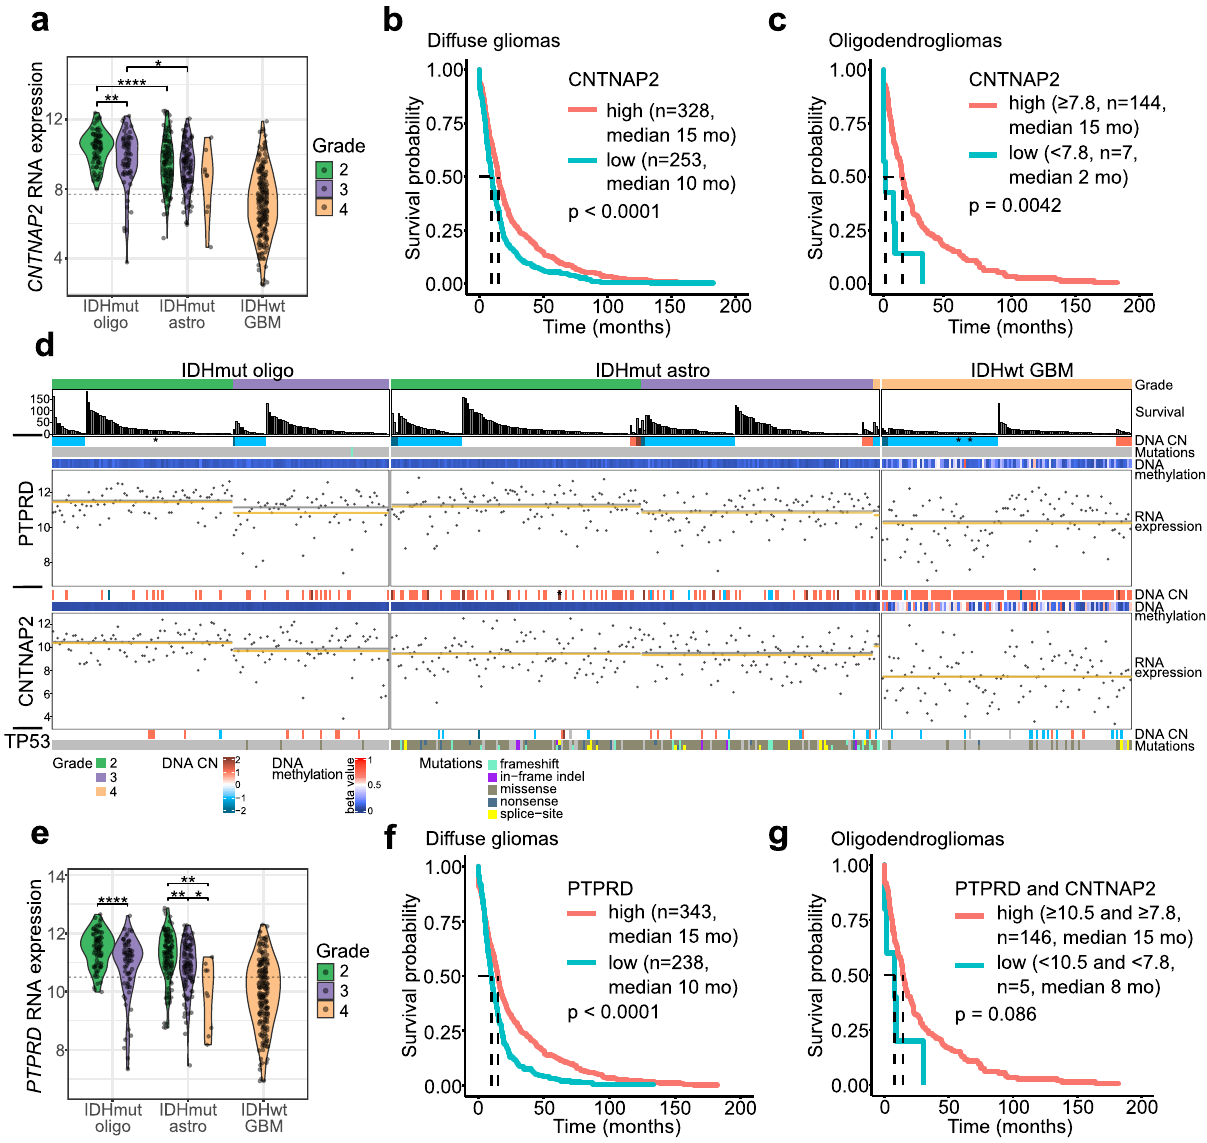
Figure 2. CNTNAP2 and PTPRD expression is associated with tumor aggressiveness and poorer patient survival. ( a ) CNTNAP2 expression in 581 diffuse glioma cases including 151 IDHmut oligodendrogliomas (oligo), 227 IDHmut astrocytomas (astro) and 203 IDHwt glioblastomas. Statistical significance was calculated between tumor grades in each subtype and between different tumor types with the same grade. *p < 0.05, **p < 0.01, and ****p < 0.0001 based on the Wilcoxon rank-sum test. Selected cutoff 7.8 for high and low expression of CNTNAP2 is marked with a dashed line. ( b , c ) Low CNTNAP2 expression was associated with poor overall survival in both b) the whole diffuse glioma cohort (581 cases, log-rank test) and c) within oligodendrogliomas (151 cases, log-rank test). ( d ) Summary of PTPRD and CNTNAP2 alterations and expression levels in diffuse glioma (482 cases with DNA methylation, DNA copy number and RNA expression data). Both DNA methylation and decreased copy number (CN) are associated with lower PTPRD expression, whereas CNTNAP2 expression was only linked to DNA methylation. Tumors harboring intragenic rearrangements of PTPRD or CNTNAP2 are indicated with an asterisk. The mean and median RNA expression are presented in yellow and gray, respectively. ( e ) PTPRD expression decreases by tumor grade in oligodendrogliomas and IDHmut astrocytomas but does not differ between tumor subtypes (581 cases, Wilcoxon rank sum test). Dashed line indicates the selected cutoff 10.5 for high and low expression of PTPRD. ( f ) Low PTPRD expression is associated with poor overall survival in diffuse gliomas (581 cases, log-rank test). ( g ) Low survival rates detected in oligodendroglioma patients with low expression of both PTPRD and CNTNAP2 (151 cases) using cutoffs of 7.8 for CNTNAP2 and 10.5 for